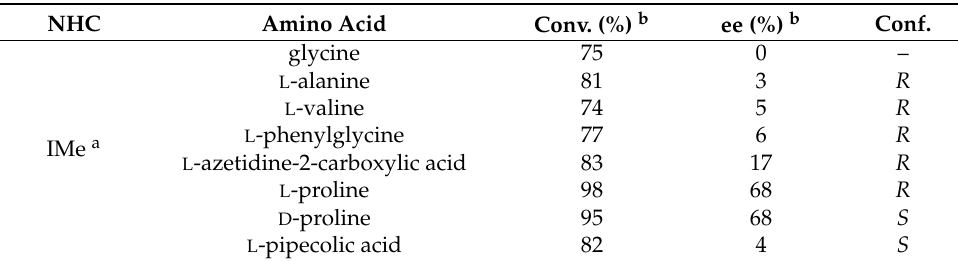
Table 4. Initial catalytic results for the ATH of acetophenone. All trials were carried out using 2.5 mol% of catalyst and 2 equiv. of NaOH in IPA at 80 °C over a period of 24 h. NHC Amino Acid Conv. (%) b ee (%) b Conf. glycine 75 0 – L -alanine 81 3 L -valine IMe a